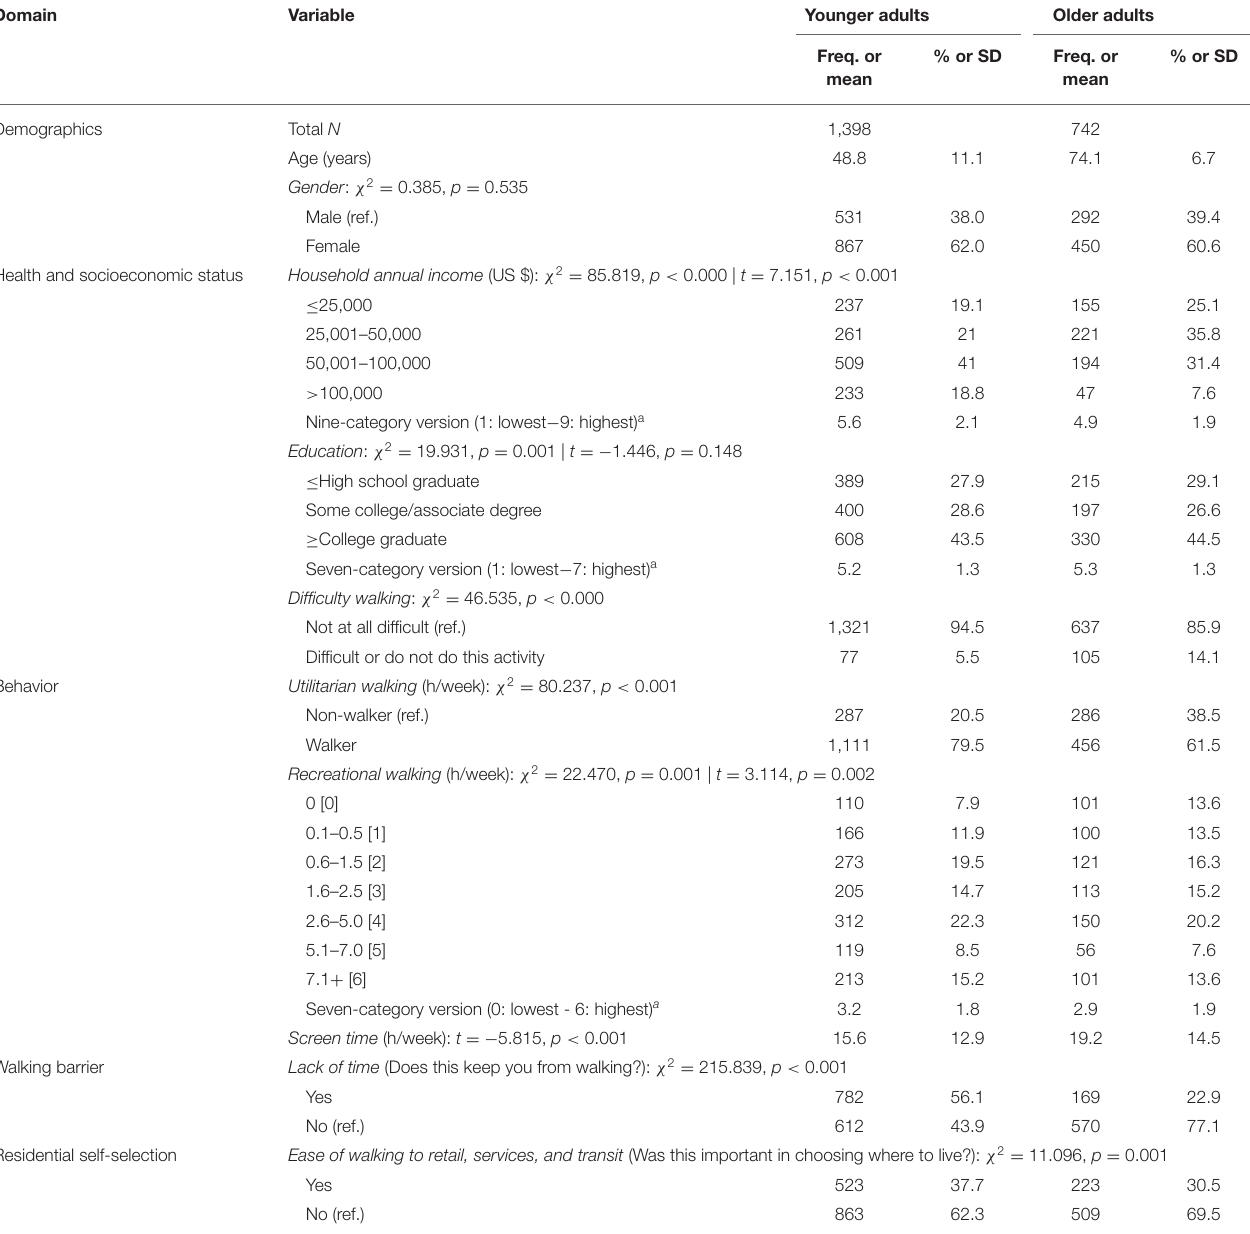
TABLE 2 | Descriptive statistics and bivariate tests of the study variables used in the final models: personal variables (survey). Domain Variable Younger adults